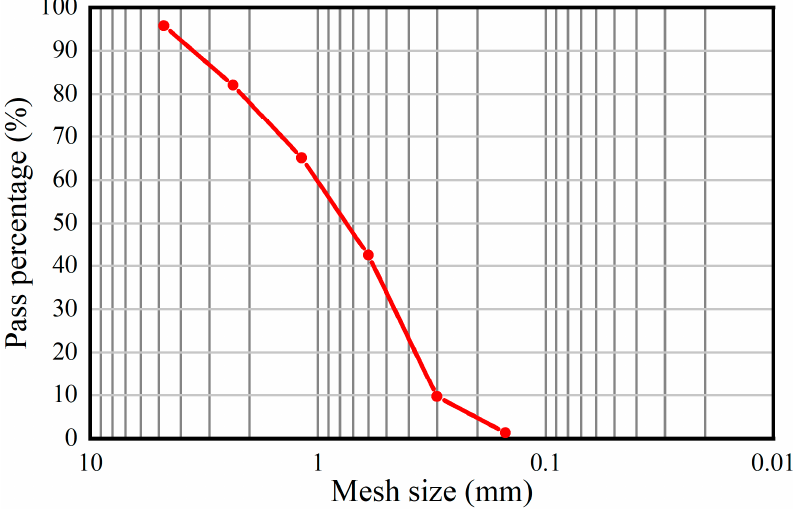
Figure 2. River sand particle gradation.